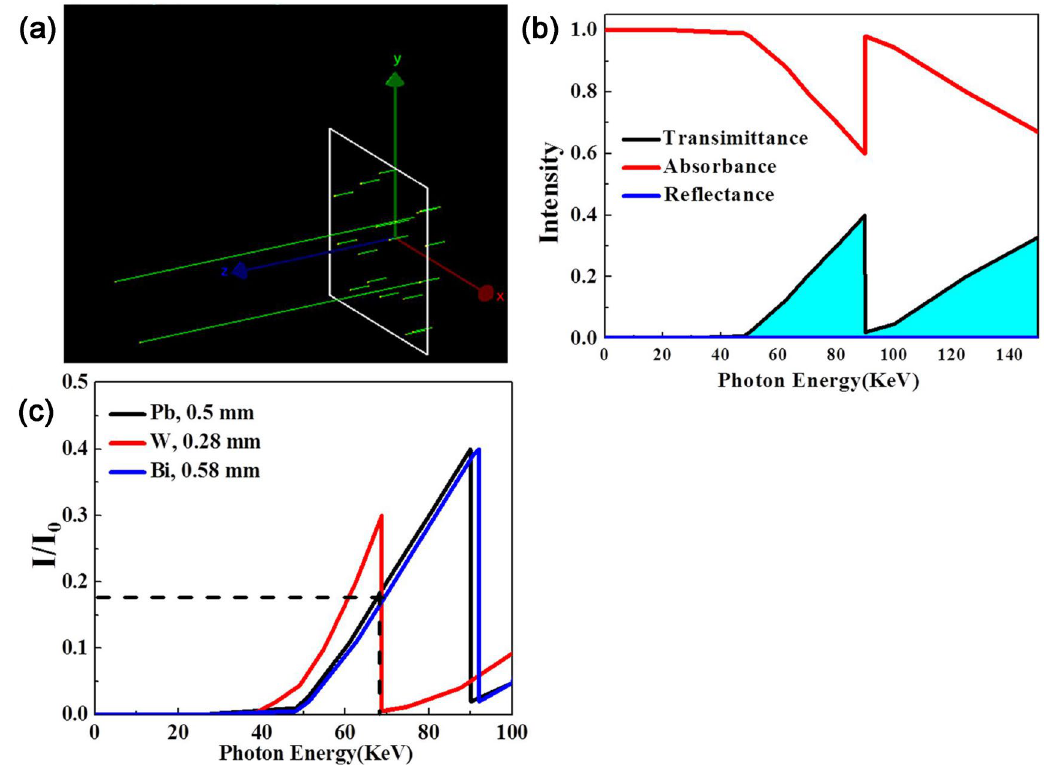
Figure 6. ( a ) The simulation process of shielding 40 photons with random energy in the range of 0–100 keV through shielding material; ( b ) Simulation results of reflection, absorption and transmission of lead materials. ( c ) X-ray transmission simulation results of lead, tungsten and bismuth pure metal materials.